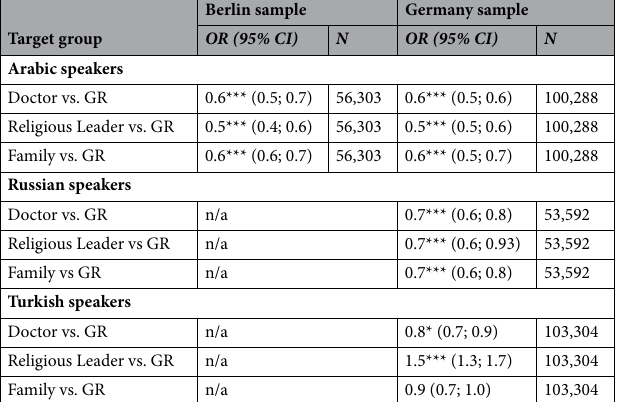
Table 3. Logistic regression model assessing likelihood of clicking on COVID-19 vaccine advertisement by messenger and campaign location, November and December 2021. Note: GR = Government representative. All cells based on separate weighted logistic regression models. Significance levels at * p < 0.10, ** p < 0.05, *** p <